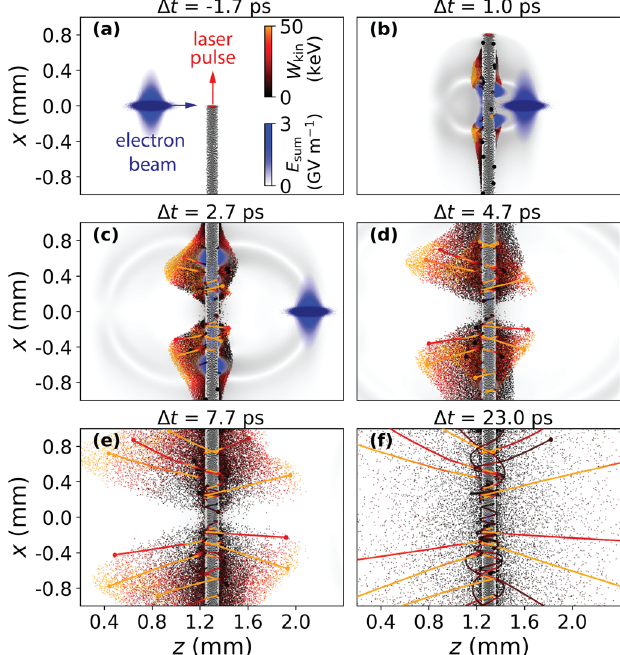
FIG. 2. PIC-simulation snapshots. (a) The electron beam approaches the emerging laser-generated H 2 = He plasma filament (black dots), reaching the filament center at Δ t ¼ 0 . (b),(c) The electron beam crosses the filament and heats plasma electrons via its unipolar transverse field (blue). Plasma surface waves (blue, central slice of simulation) propagate along the filament and transport density perturbations. (d) – (f) Localized plasma electron oscillations visualized by typical electron trajectories (solid lines), color coded by momentary